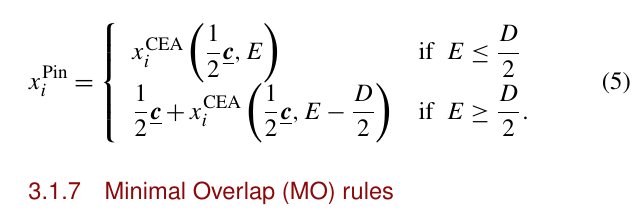
Table 1. The rate of contribution and claim of riparian countries on the Euphrates River (Beaumont, 1998; Ibrahim et al., 2004).